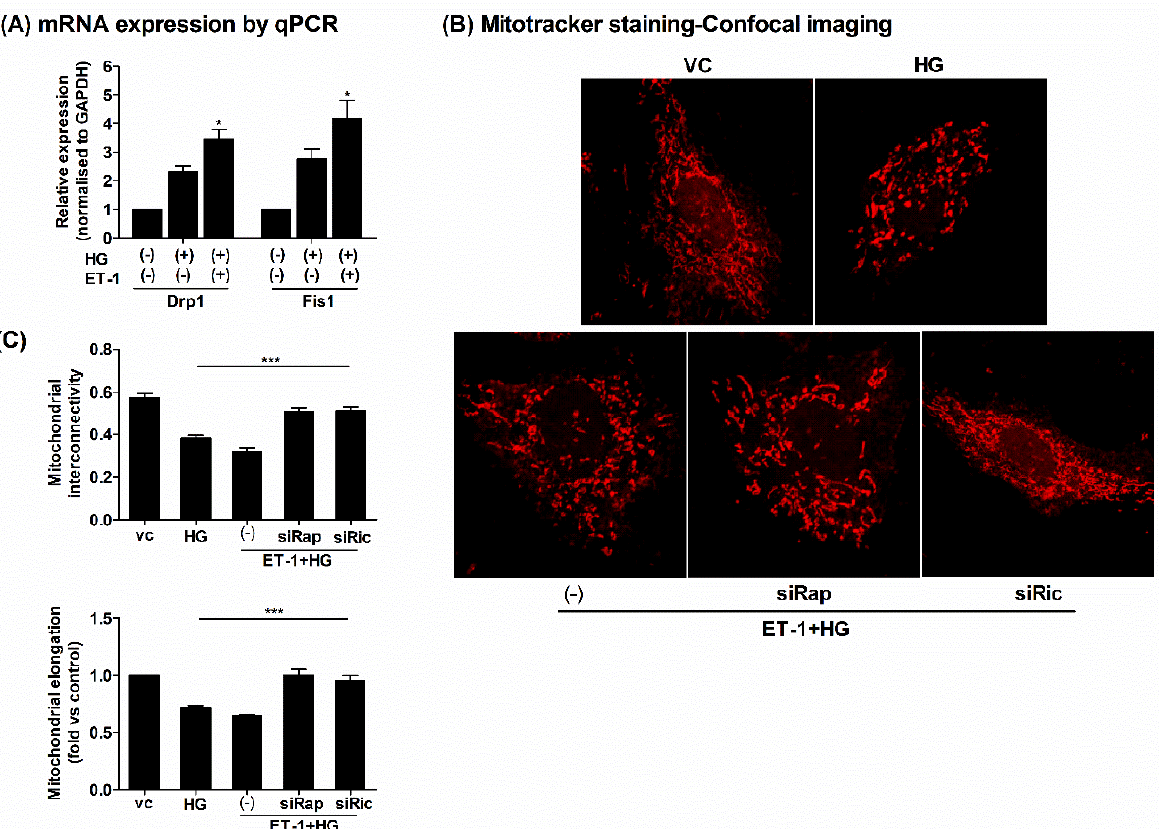
Figure 4. Inhibition of mTOR improved the mitochondrial damage under HG conditions in H9c2 cells. The H9c2 cells were seeded in 12-well culture dishes on gelatin-coated coverslips in low glucose DMEM medium. Next, the cells were transfected with siRNAs targeting Raptor/Rictor or control siRNAs for 24 h followed by ET-1 (20 nM) treatment for 3 h, followed by HG treatment for another 24 h. ( A ) The total RNAs were extracted, and q-PCR was performed to assess mRNA expressions of mitochondrial fission-related genes Drp1 and Fis1. The mRNA expressions were normalized to GAPDH and expressed as fold versus controls (vc) (2 −ΔΔ CT ). ( B ) At the end of designated treatments, mitochondrial morphology was assessed, employing MitoTracker red labeling using confocal microscopy, and quantification is depicted in figure ( C ); the mitochondrial